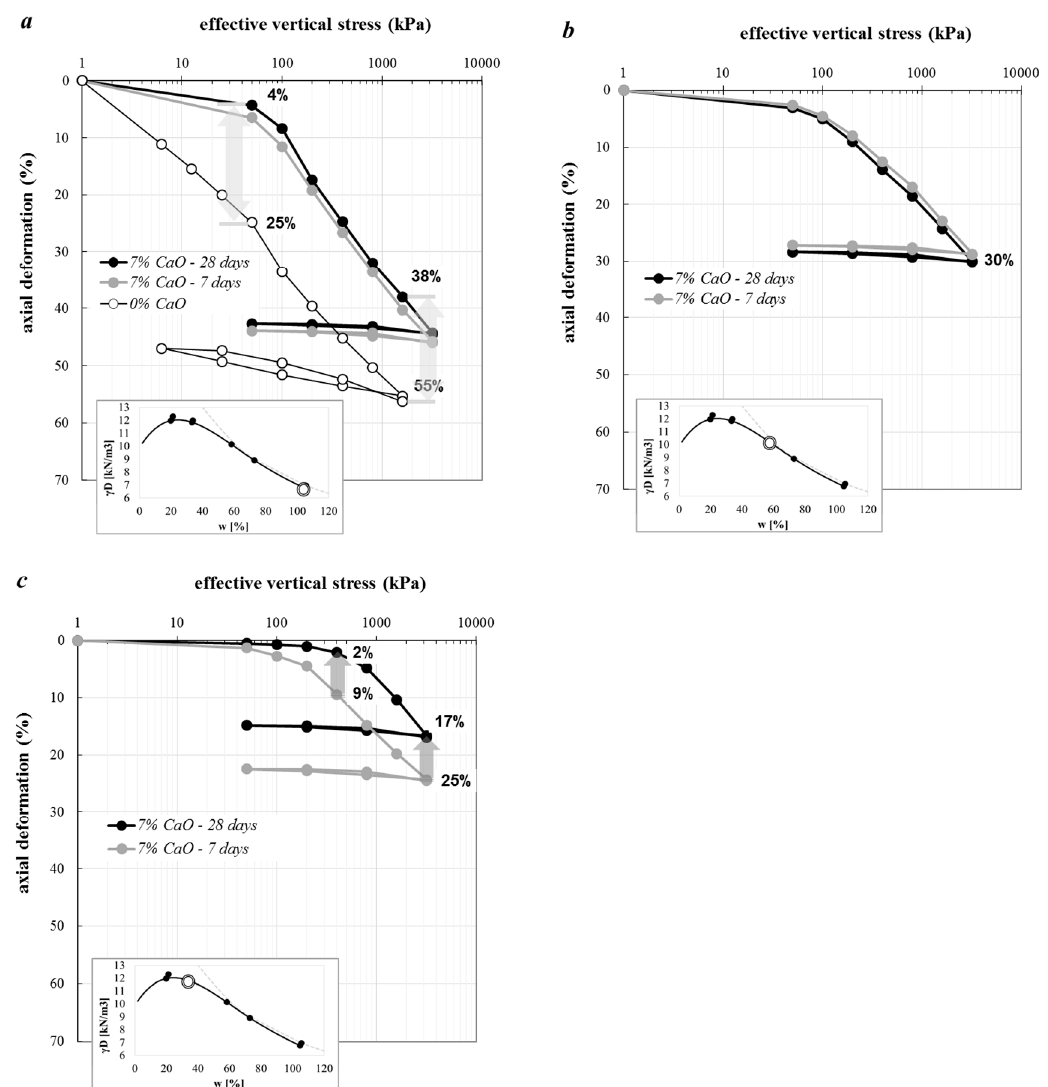
Figure 9. Compressibility curves of soil treated with 7% CaO, at 7 and 28 days of curing, compacted at different water content: ( a ) natural water content, ( b ) w = 58%, i.e., wet of optimum, and ( c ) optimum water content. In Figure (a), the compressibility curve of the untreated compacted specimen is also plotted.